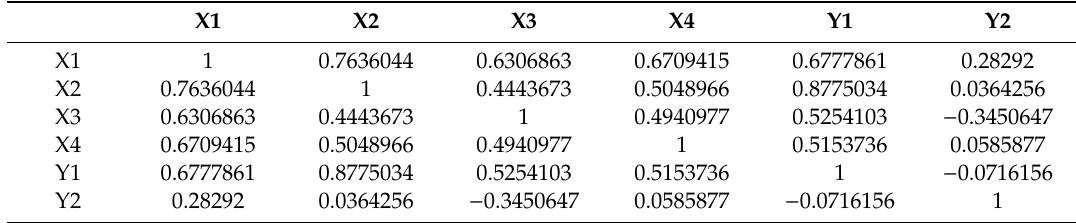
Table 5. Pearson correlation coe ffi cients obtained for the year 2017.